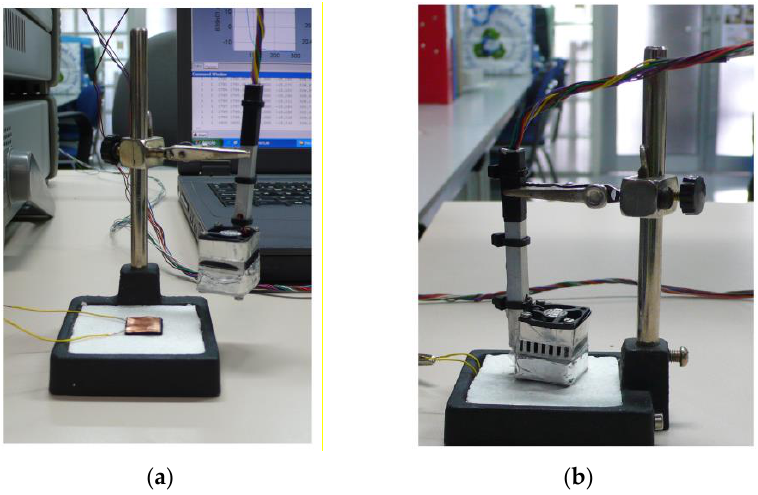
Figure 2. Base with the calibration resistor ( a ) and the sensor placed on the calibration base ( b ).